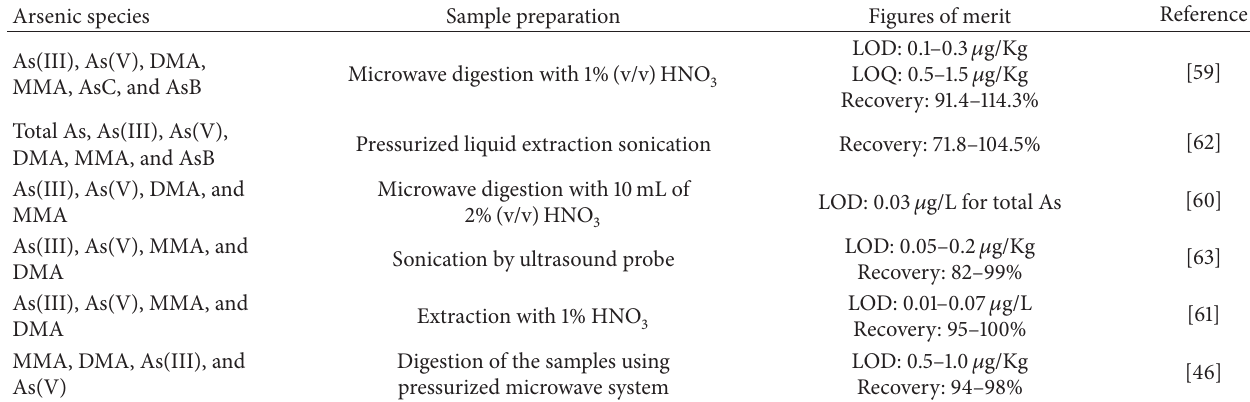
Table 2: Speciation of arsenic in rice using